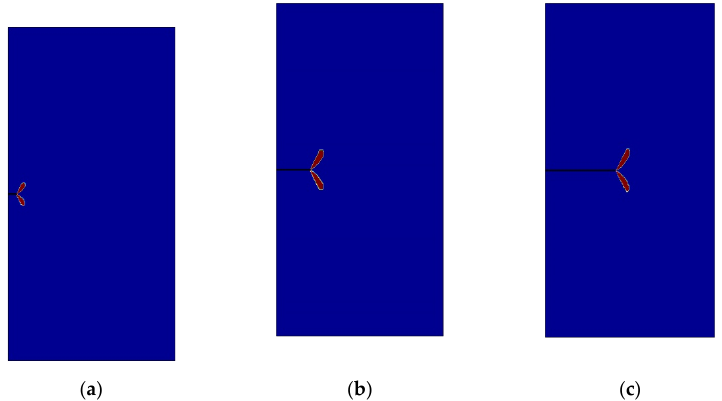
Figure 9. Evolutions of plastic zone during hydraulic fracturing after the following times: ( a ) 1.6 × 10 1 s; ( b ) 1.23 × 10 2 s; and ( c ) 3.58 × 10 2 s.